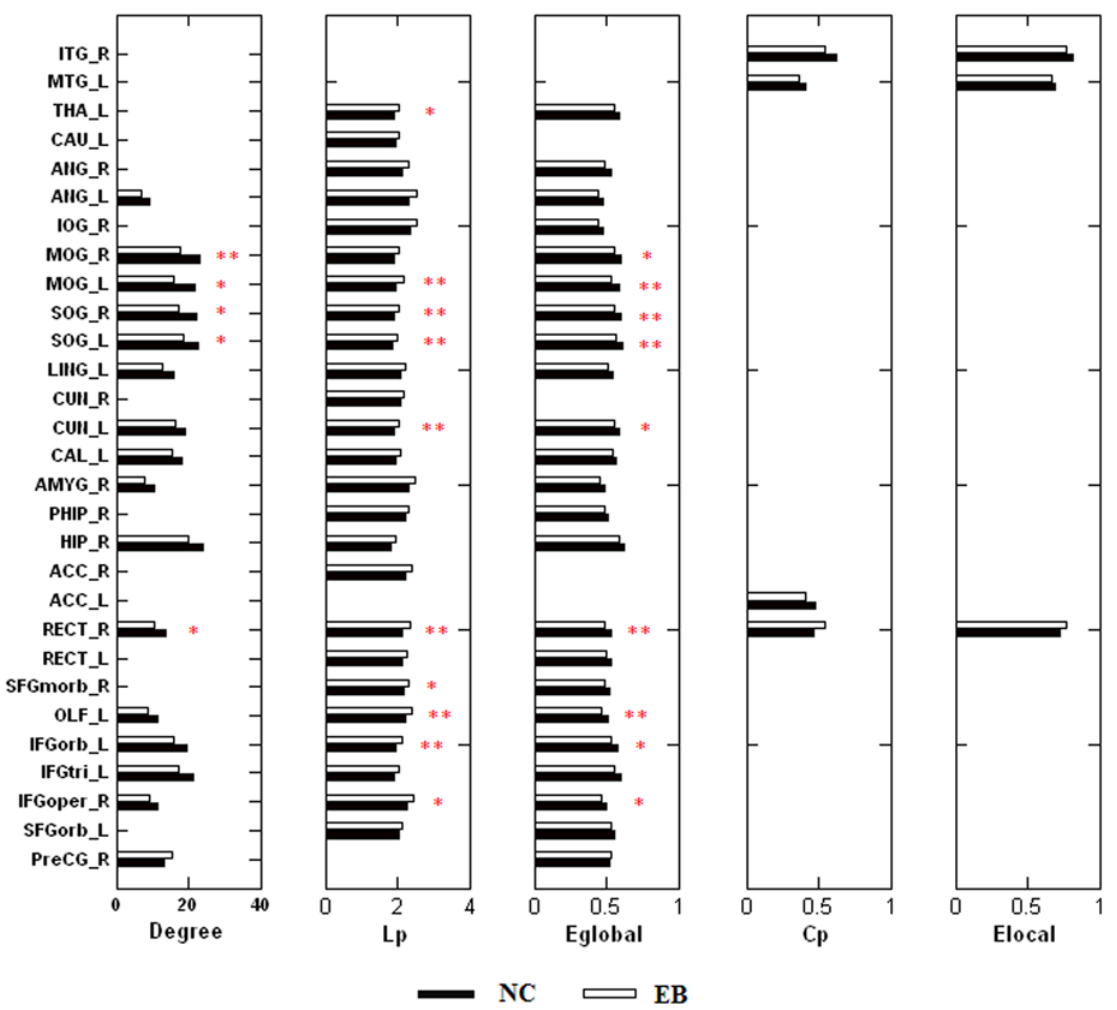
Figure 2. Distribution of regions with significantly altered nodal properties in early blind subjects. The length of the bar indicates the mean values of the topological measurements (Degree: K i ; Lp: L i ; Eglobal: E i_glob ; Cp: C i ; Elocal: E i_loc ) of each altered brain region. Black bars represent normal group, and open bars represent early blind group. (Unstarred bars: significance with p , 0.05; *: p , 0.01; **: p , 0.005).